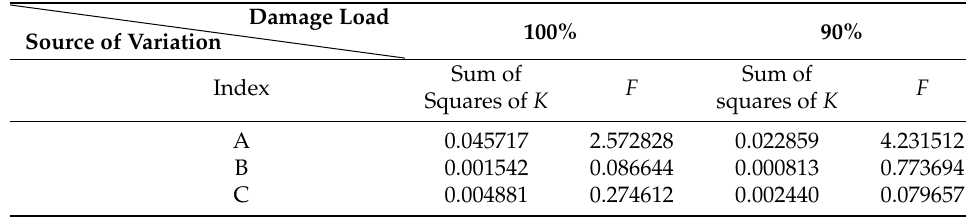
Table 11. Ultrasonic sound speed recovery rate (age of 7 d).